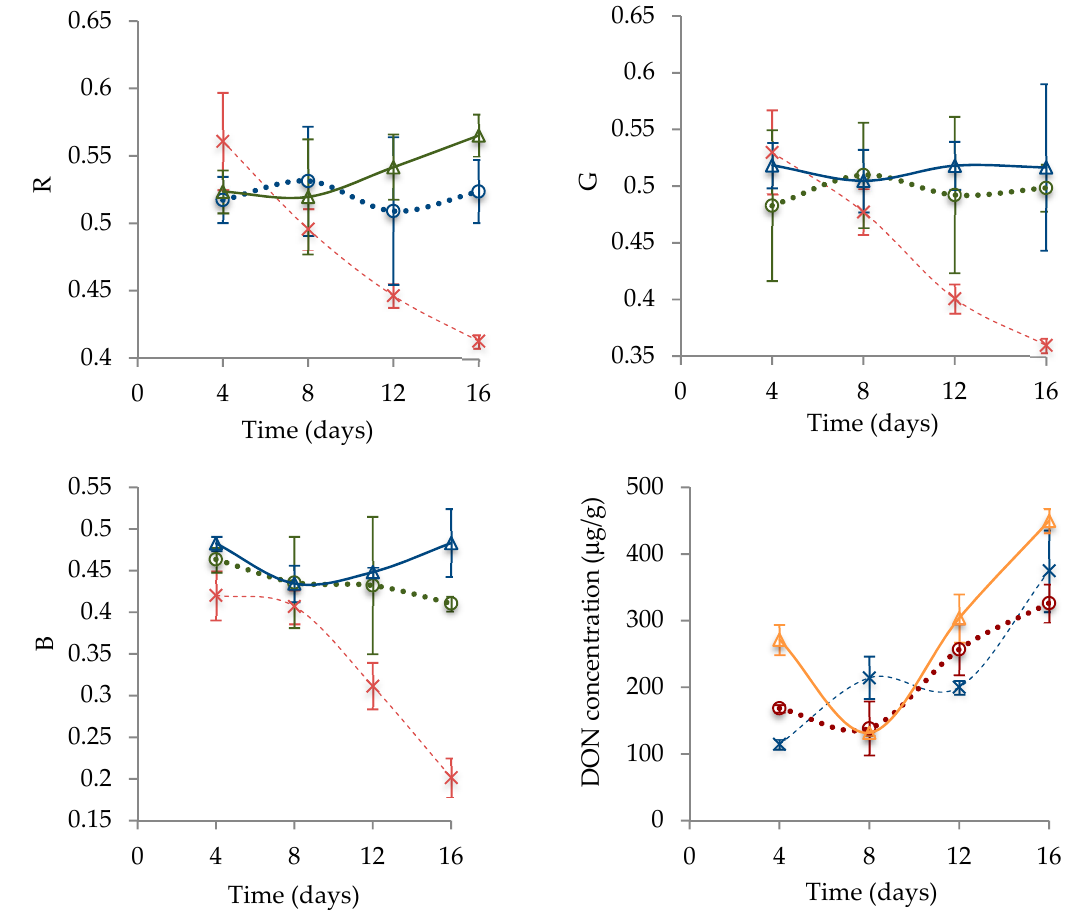
Figure 5. Variation of RGB components and DON concentration over time under different a w . Note: R = red; G = green; B = blue; a w = 0.94 ( Δ ); a w = 0.97 (O); a w = 0.99 ( × ). Only the RGB channels at a w = 0.99 could be used as independent variables to plot with DON concentration (Figure 6) because colors did not change significantly at lower a w .